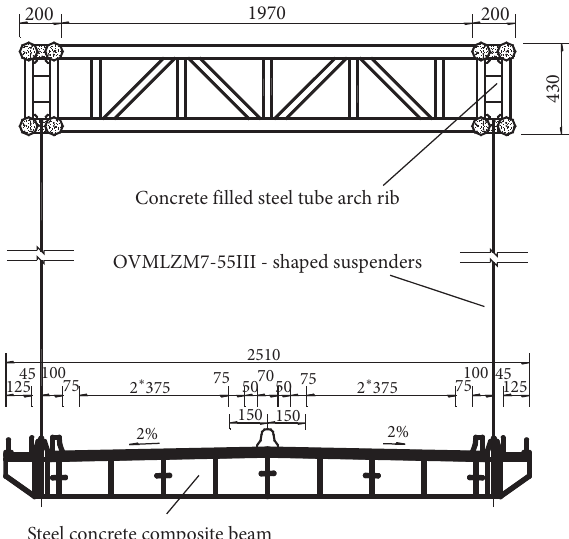
Figure 3: The I-I cross-section (unit: cm).